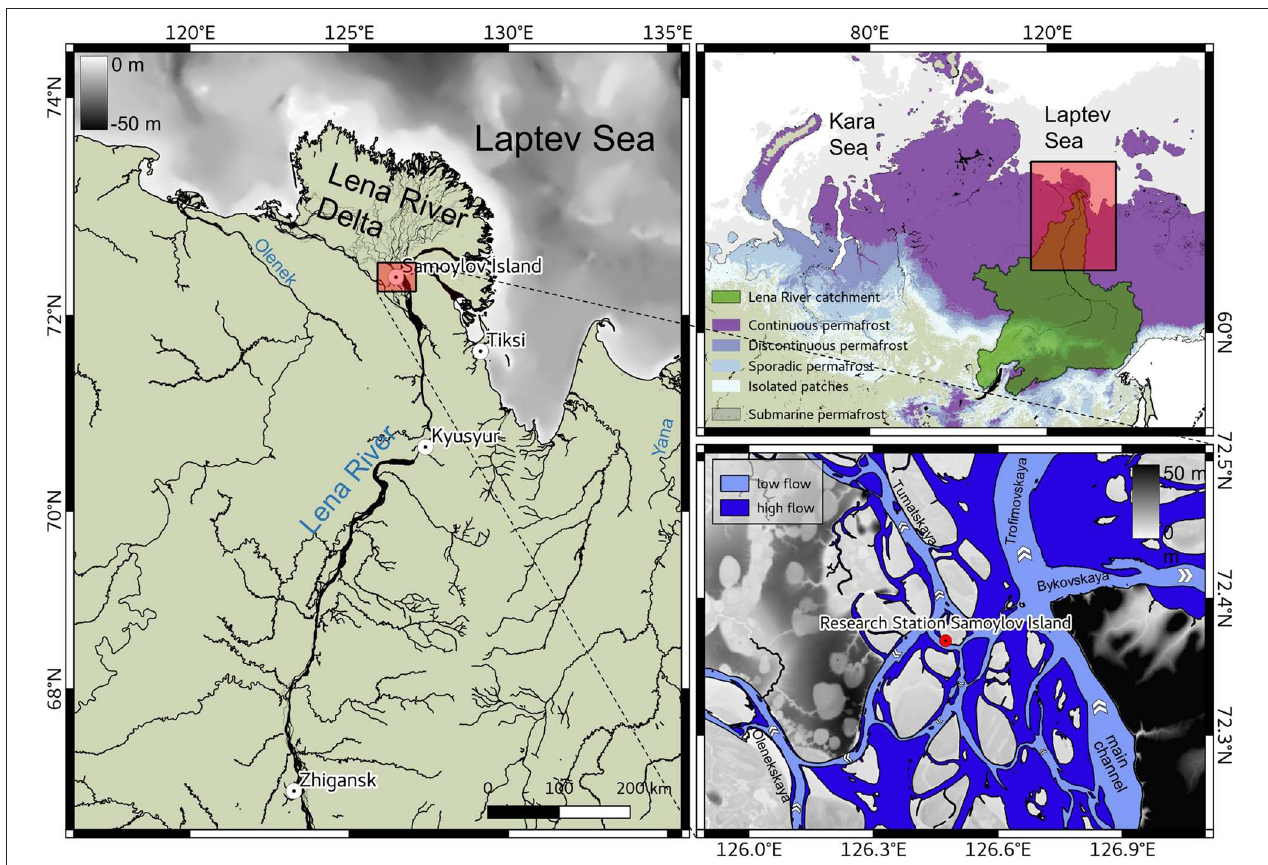
FIGURE 1 | Lena River Delta region. The upper right panel shows an overview map of the study area with permafrost zones (Obu et al., 2019; Overduin et al., 2019). The left panel shows the northern part of the Lena River catchment with the Lena River Delta at the coast of the Laptev Sea. The lower right panel the central Lena River Delta with the location of the Research Station Samoylov Island and the Lena River channels (blue) and flow directions; DEM is based on ArcticDEM ( Porter et al., 2018 ). Dark blue indicates Lena River channels during high flow right after spring ice break-up and light blue indicates Lena River channels during low flow in late summer (based on Sentinel 2 imagery 1